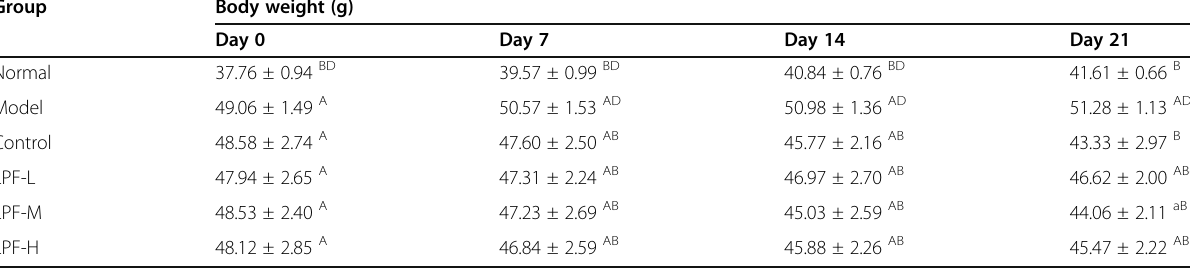
Table 3 Effect of flavonoids from L. plumule on body weight of diabetic mice Group